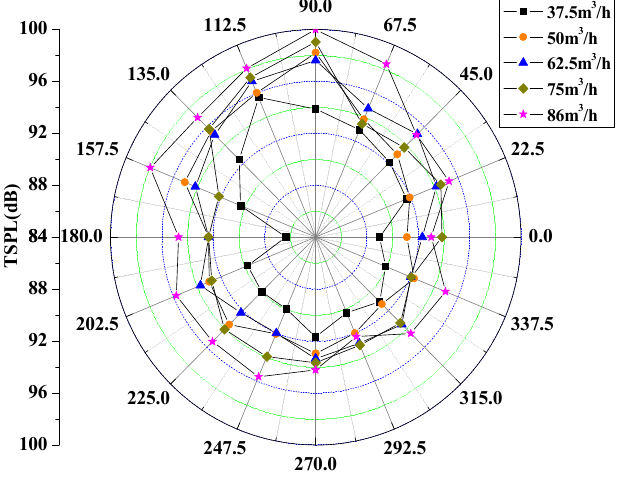
Figure 9. Directivity characteristics of radiation noise under various flow rate conditions (2900 rpm).